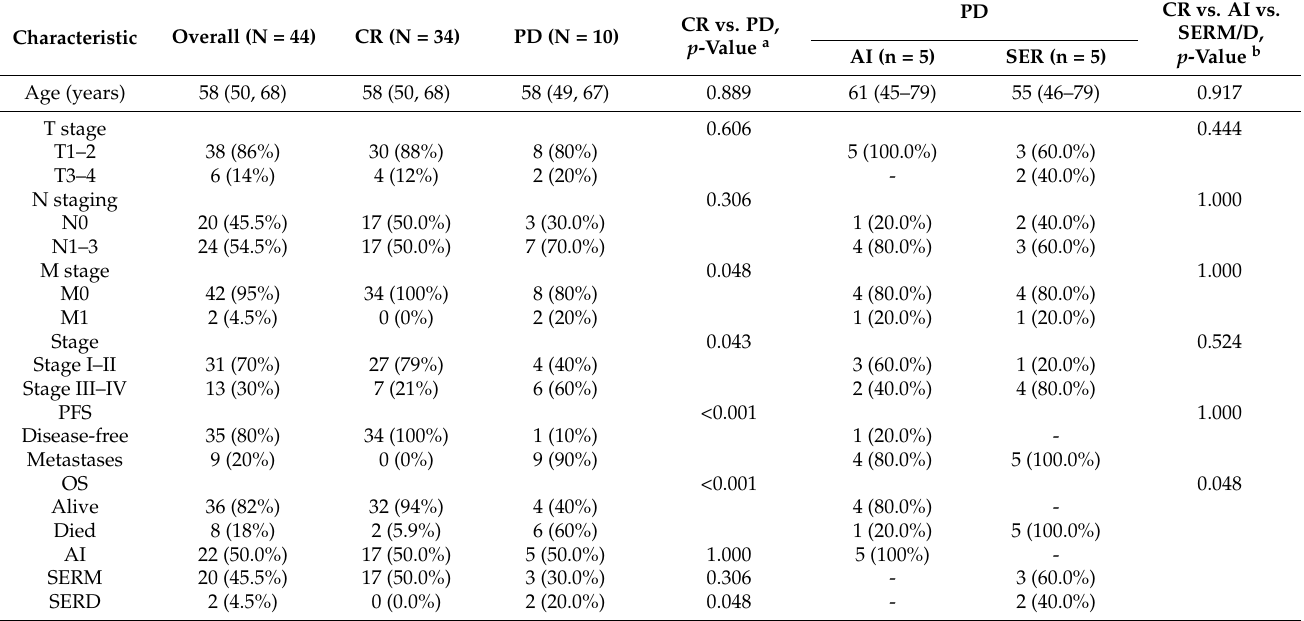
Table 1. Baseline distribution of (non-TNBC) study